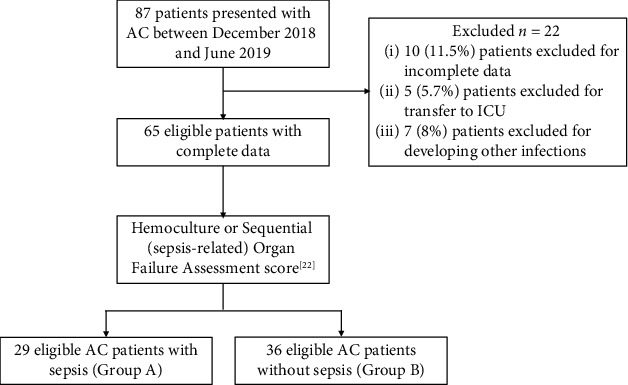
Flow chart showing the selection of patients for inclusion in the study.